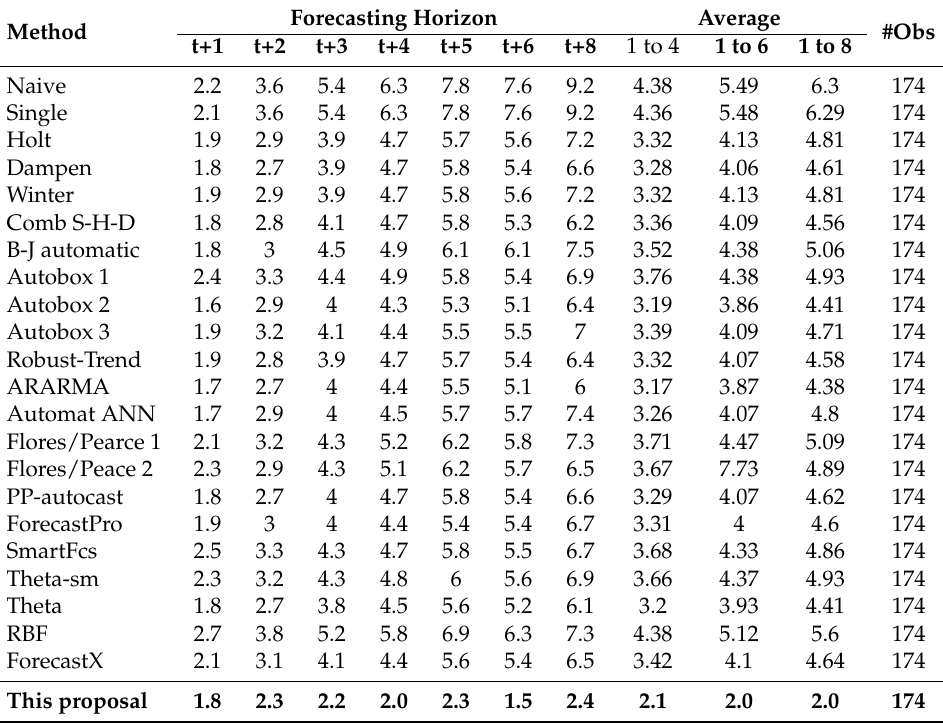
Table 8. SMAPE on M3-Competition for other